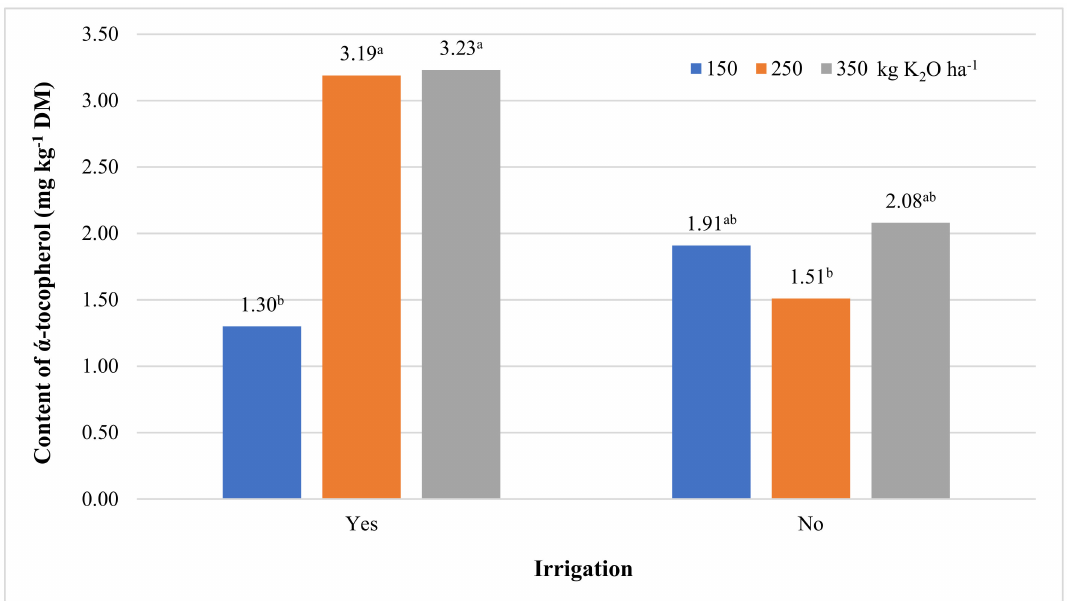
Figure 2. The e ff ects of irrigation and potassium fertilization on the ´ α -tocopherol content of tubers in the analyzed Jerusalem artichoke cultivars. Means with the same letters do not di ff er significantly at p ≤ 0.05 in Tukey’s test. The absence of letters denotes non-significant main e ff ects. Vitamin A activity is determined in retinol equivalents (RE) [46,62]. Raju et al. [46] analyzed the activity of provitamin A in 30 species of leafy vegetables and reported the highest value in broccoli (641 RE) and the lowest value in sorrel (12 RE). In the present experiment, vitamin A activity in Jerusalem artichokes was determined in the range of 125–167 RE, and it was higher in non-irrigated tubers (Table